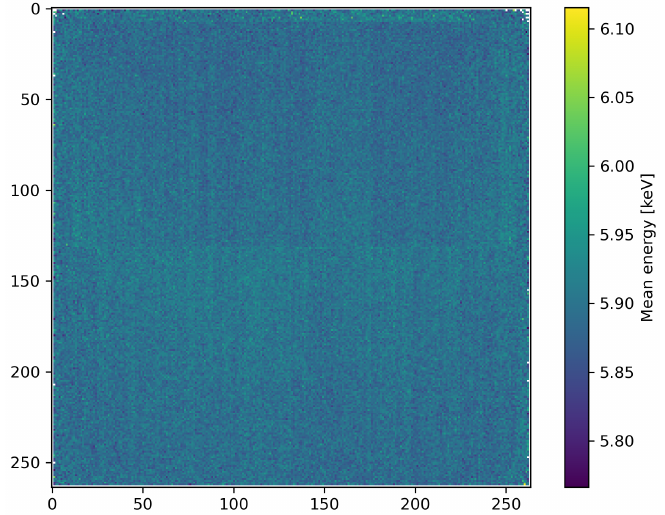
Figure 3. Example of the mean energy view, showing the mean photon energy of all events in the range 5.75 to 6.15keV, which includes the 5.9keV Mn K α peak of a Fe 55 calibration source. The mean energy view shows very small variations in spectrum, highlighting the structure of the pnCCD sensor in a slight mismatch of calibration. The Fe 55 calibration source used for this figure is very weak with an overall flux below 1 × 10 3 phs − 1 cm − 2 , leading to negligible